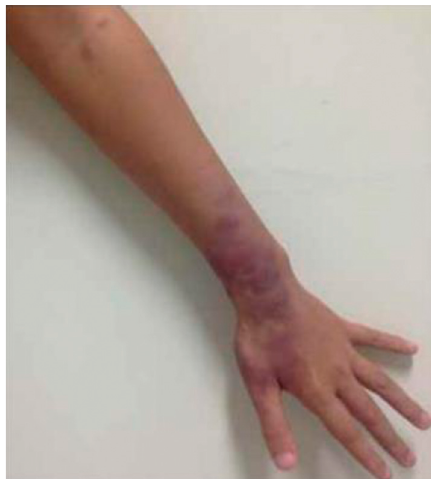
Figure 4: Type 1 reaction: lesions with erythema, swelling, papules, and plaques (photograph courtesy of Oliveira, et al.) [20].